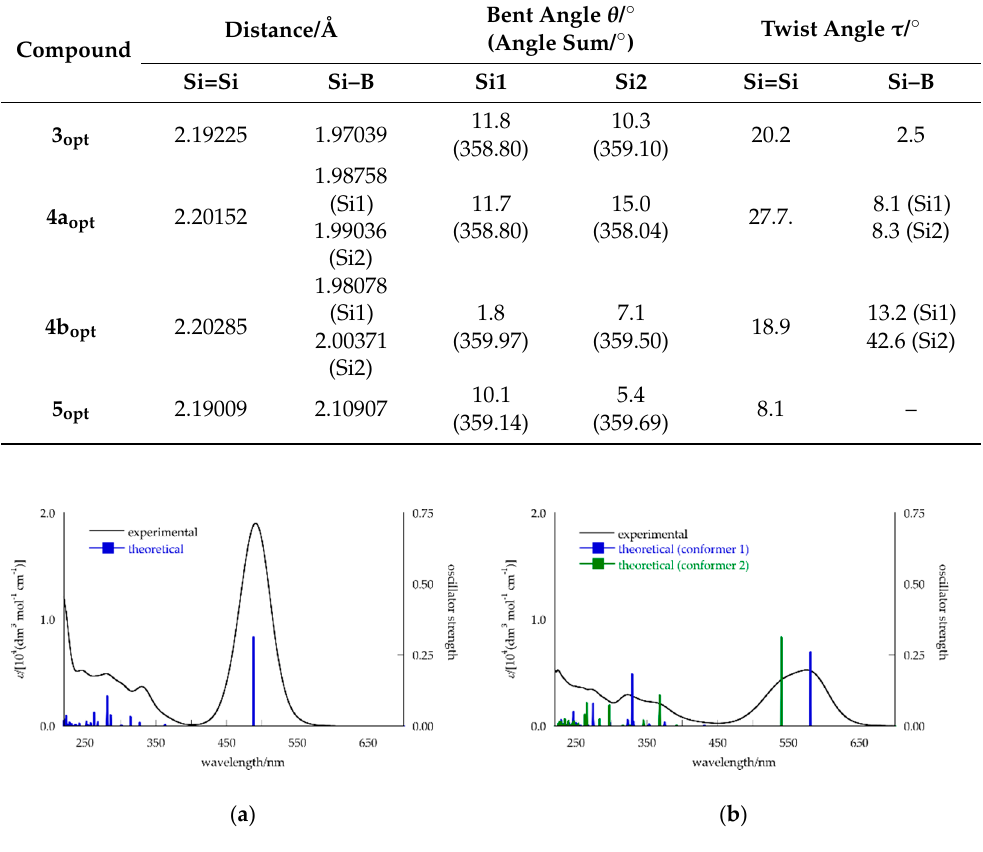
Table 2. Selected structural parameters of 3 , 4 , and 5 calculated at the B3PW91-D3/6-31G(d) level of theory.